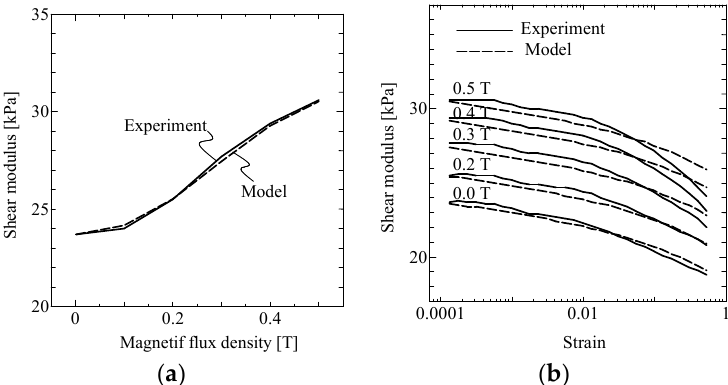
Figure 2. MR effects of MRE in uniform MF. ( a ) MF dependence of shear modulus for small strain (0.01%), and ( b ) strain dependence of shear modulus, for different MF intensities.